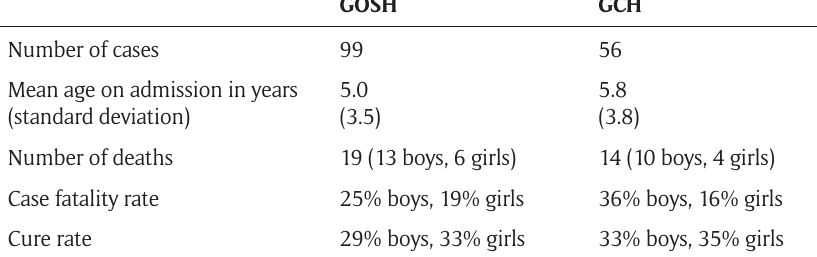
Table 1: Vital data for admissions to Great Ormond Street Hospital (GOSH) and Glasgow Children’s Hospital (GCH) for patients admitted with